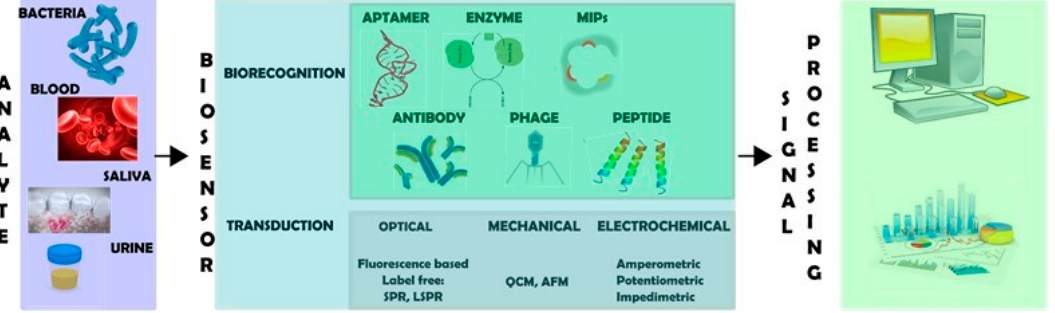
Figure 1. Schematic representation of the biosensing process. A biosensor has two main components: a biorecognition moiety that interacts with analytes and a transducer that converts such interaction into a measurable signal.